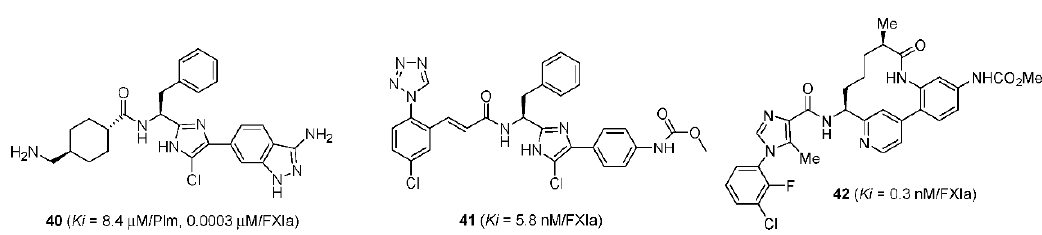
Figure 3. Structure of compounds 40–42 [37–40] developed by Bristol-Myers Squibb (BMS).